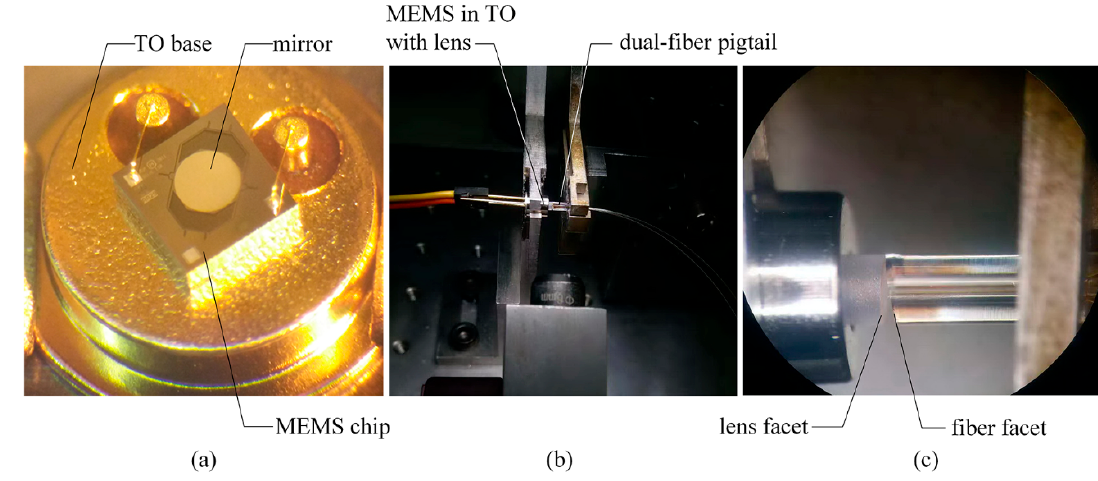
Figure 6. Alignment and assembly of the MEMS VOA. ( a ) MEMS chip assembled on a TO base, ( b ) optical alignment of the VOA, ( c ) enlarged view between the lens and fiber facets.